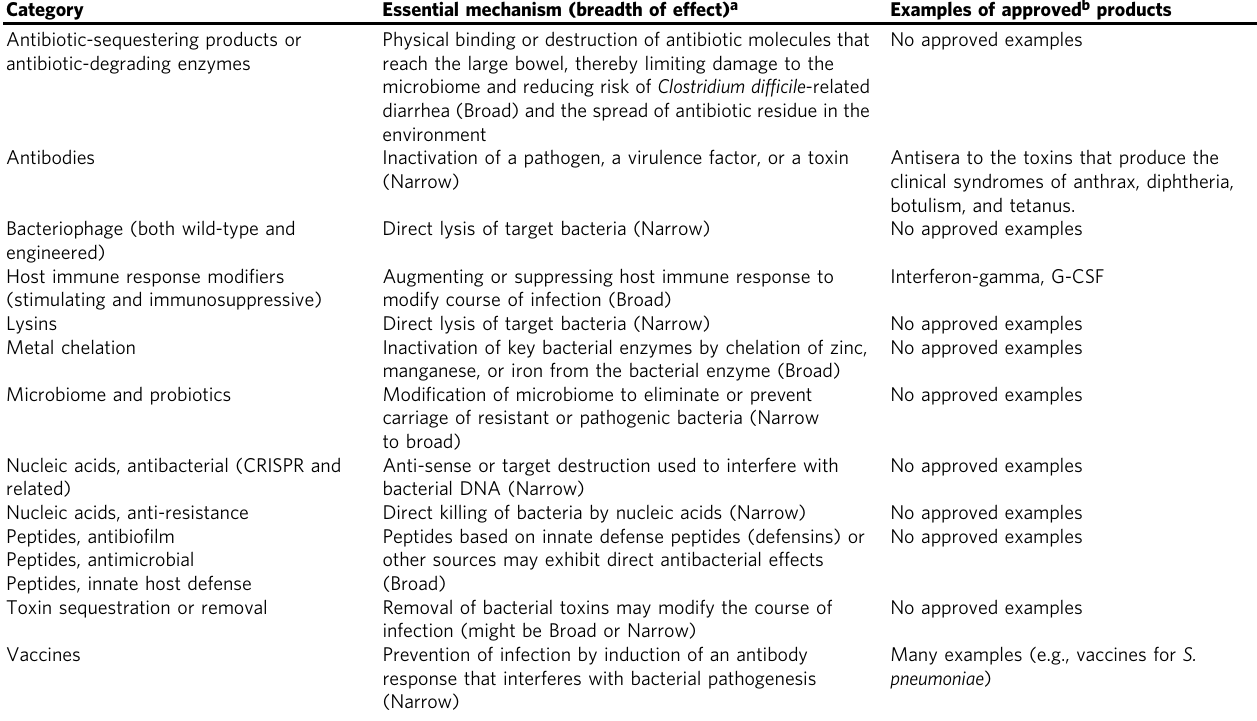
Table 1 The wide range of non-traditional antimicrobial agents Category Essential mechanism (breadth of effect) a Examples of approved b products Antibiotic-sequestering products or antibiotic-degrading